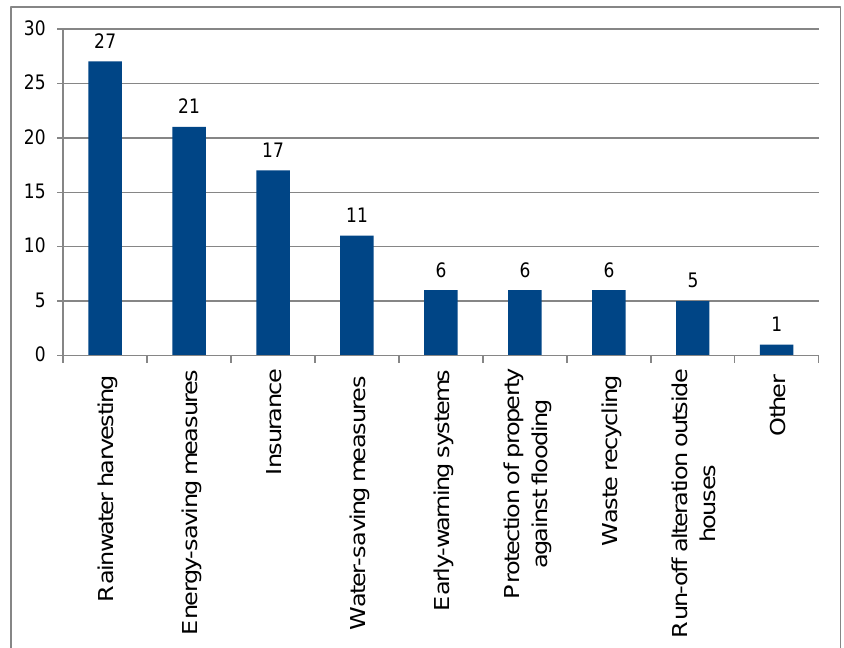
Figure 1. Individual adaptation measures already taken by respondents (% respondents, N = 522).